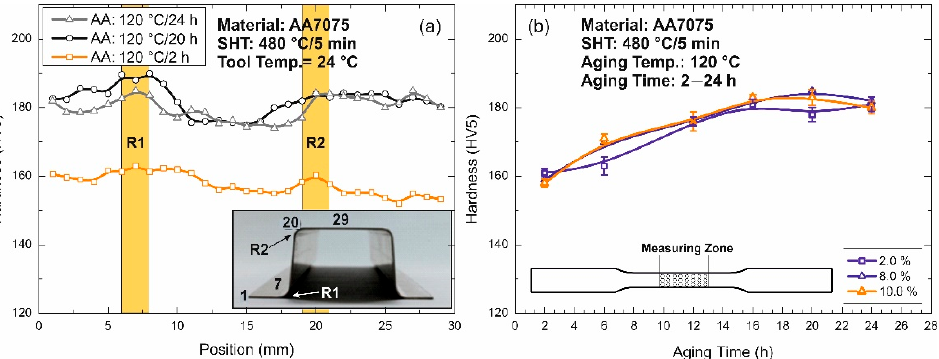
Figure 5. ( a ) Hardness profile of the hot-formed components after different artificial aging (AA) times. The sheet materials were first solution-annealed and then quenched within the forming tools. ( b ) Hardness evolution of samples at different deformation levels and aging times of emulated process route. The zone of 15 mm × 7.5 used for hardness measurement for all formed conditions is shown in ( b ).